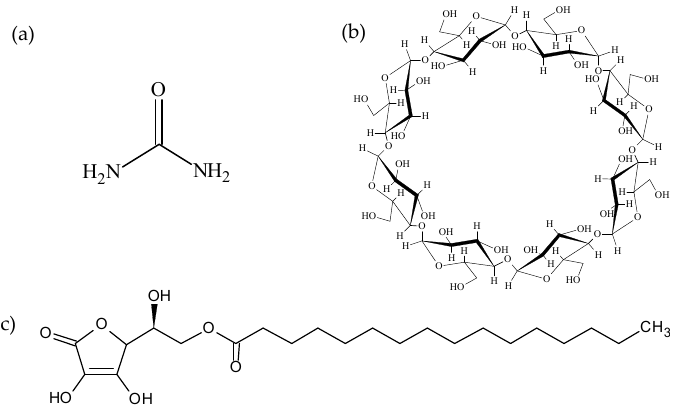
Figure 1. Chemical structures of ( a ) Urea (UR), ( b ) γ -Cyclodextrin ( γ CD), ( c ) ASCP .